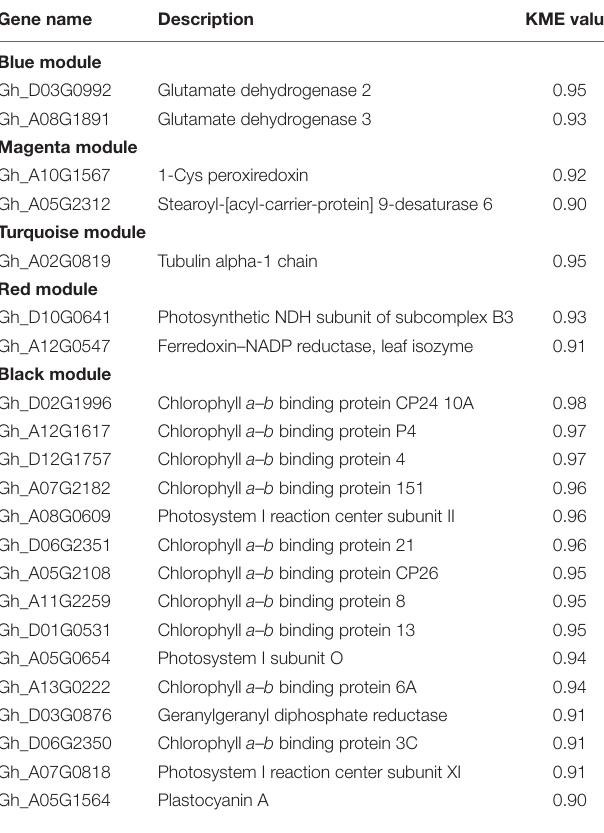
TABLE 1 | List of the candidate hub genes in the red, magenta, black, blue, and turquoise